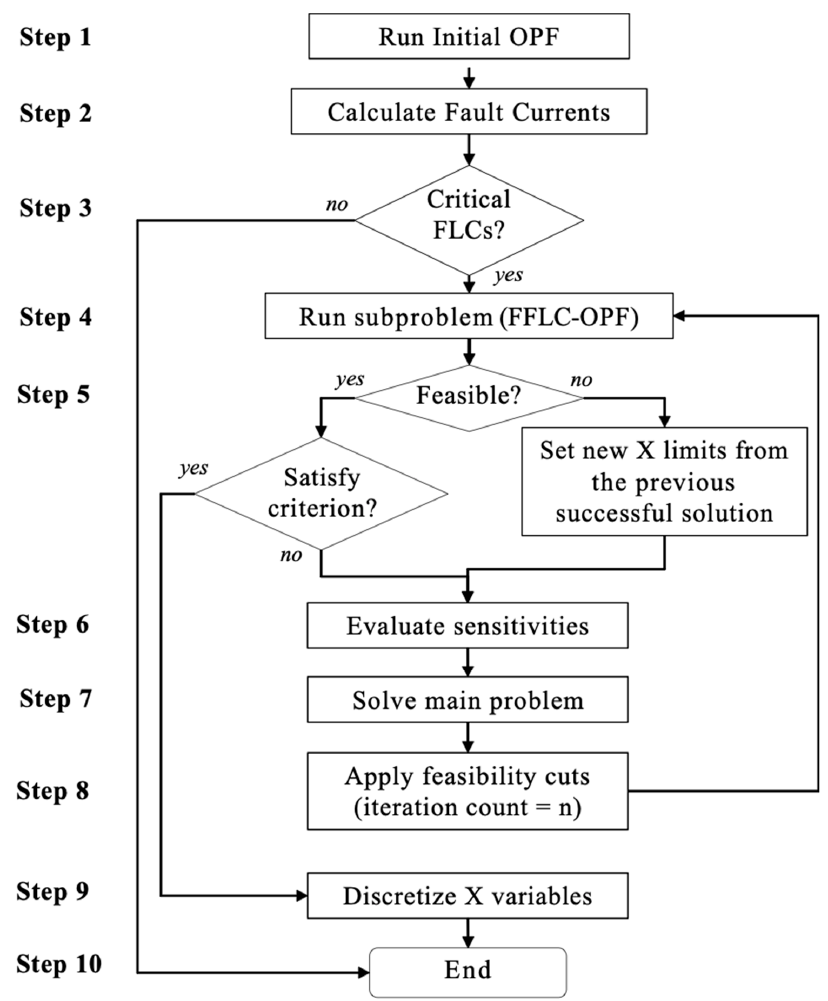
Figure 3. Flowchart of the overall procedure. OPF: optimal power flow; FLCs: fault level constraints; FFLC-OPF: fuzzy fault level constrained optimal power flow.